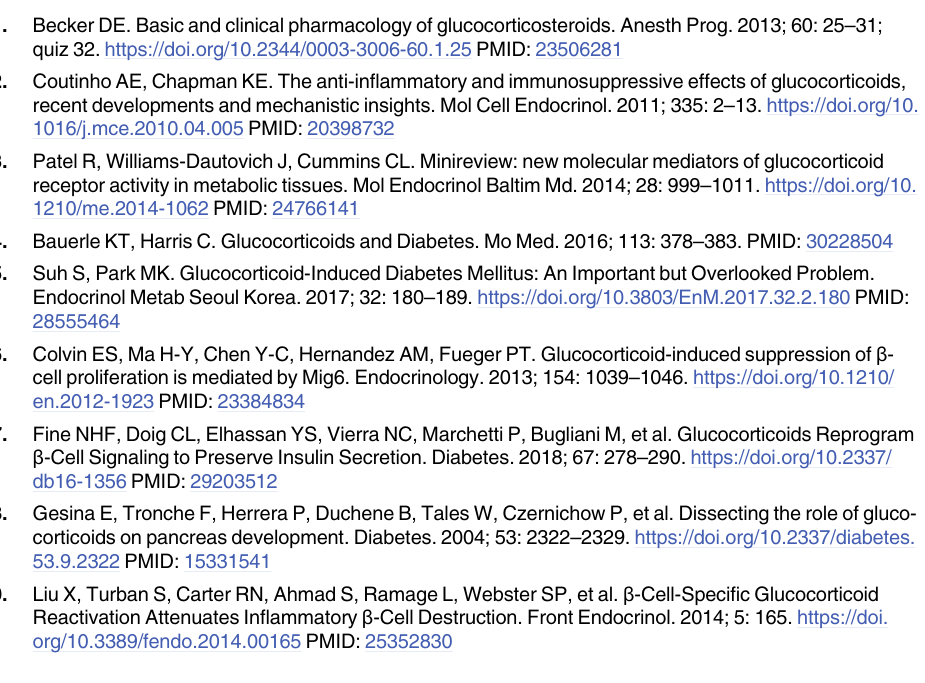
S1 Data. Source data. Data underlying Figs 2F and 4E in the